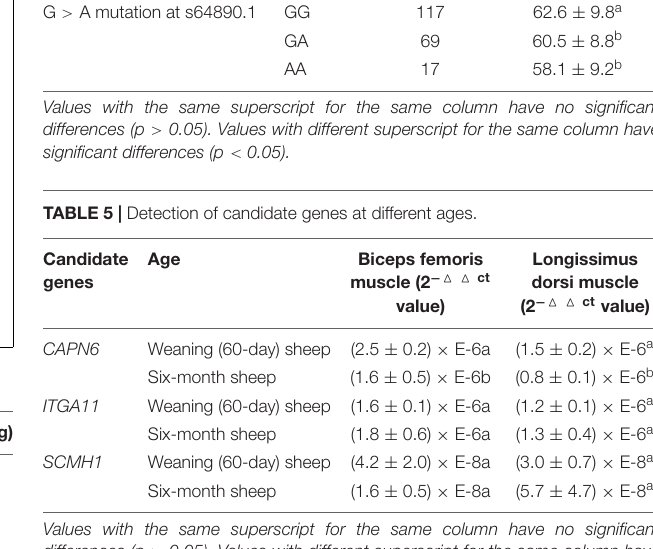
significant differences (p <